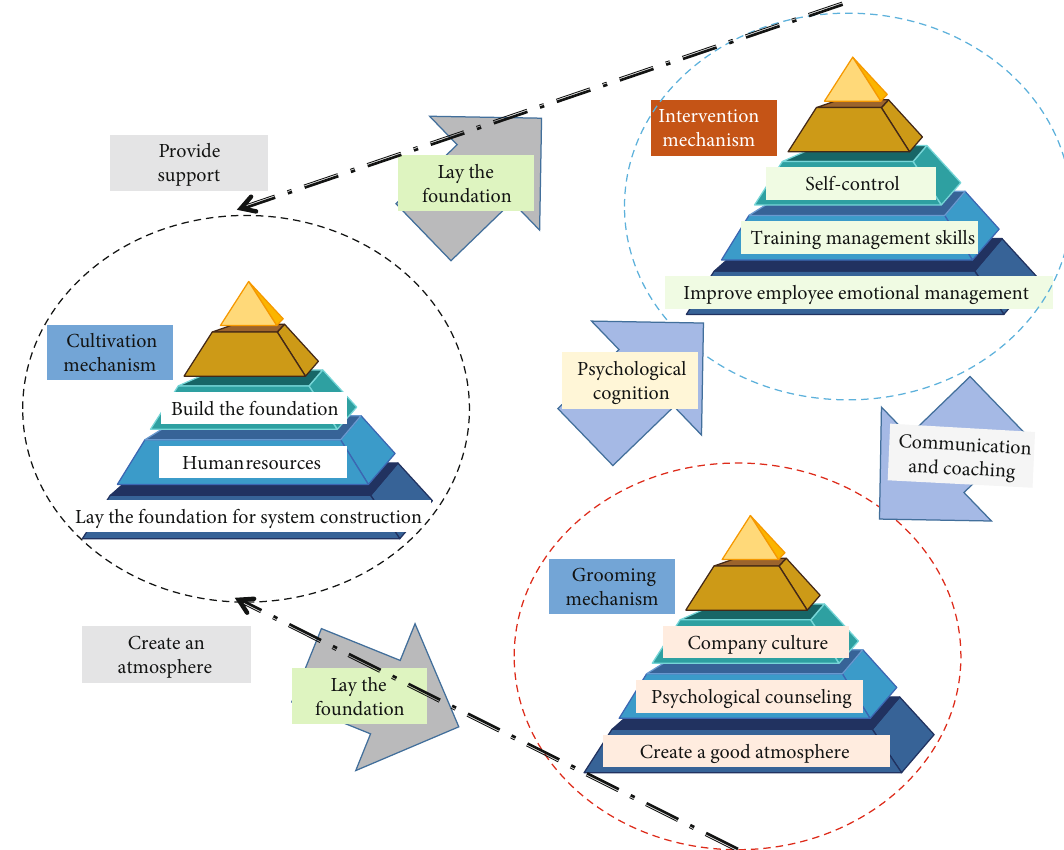
Figure 1: Construction of enterprise employee emotion management